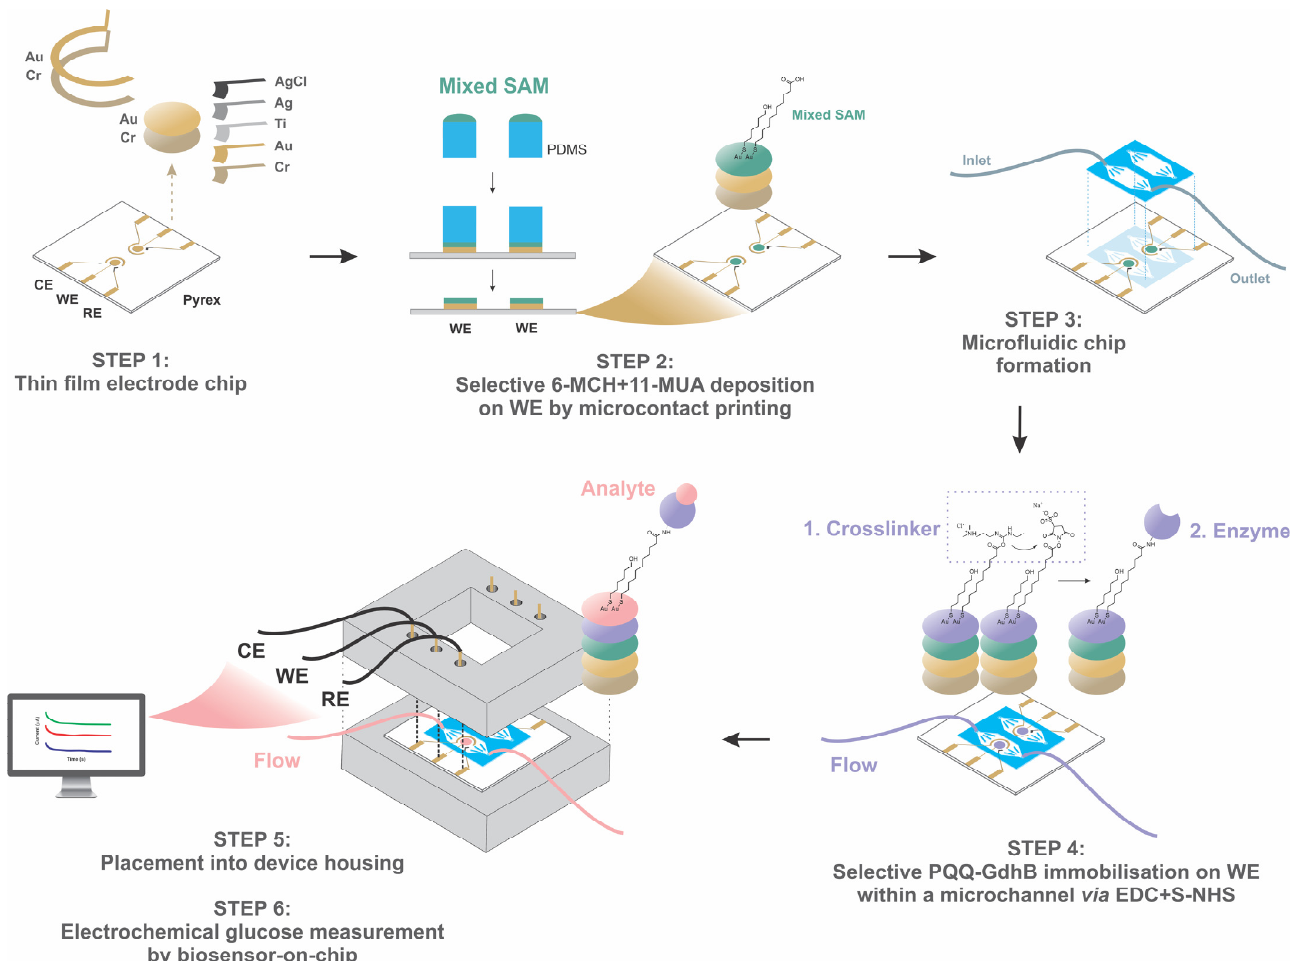
Figure 1. Construction of electrochemical PQQ-GdhB biosensor on a chip for glucose measurement. Step 1: Thin-film working and counter Au electrodes with Ag/AgCl reference electrode; Step 2: Se-